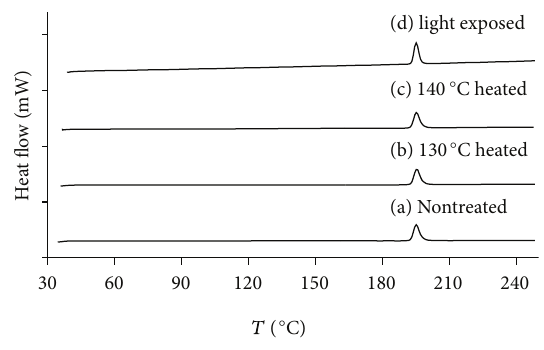
F 5: Differential scanning calorimetry thermogram of drospirenone in silicone elastomer compared nontreated with